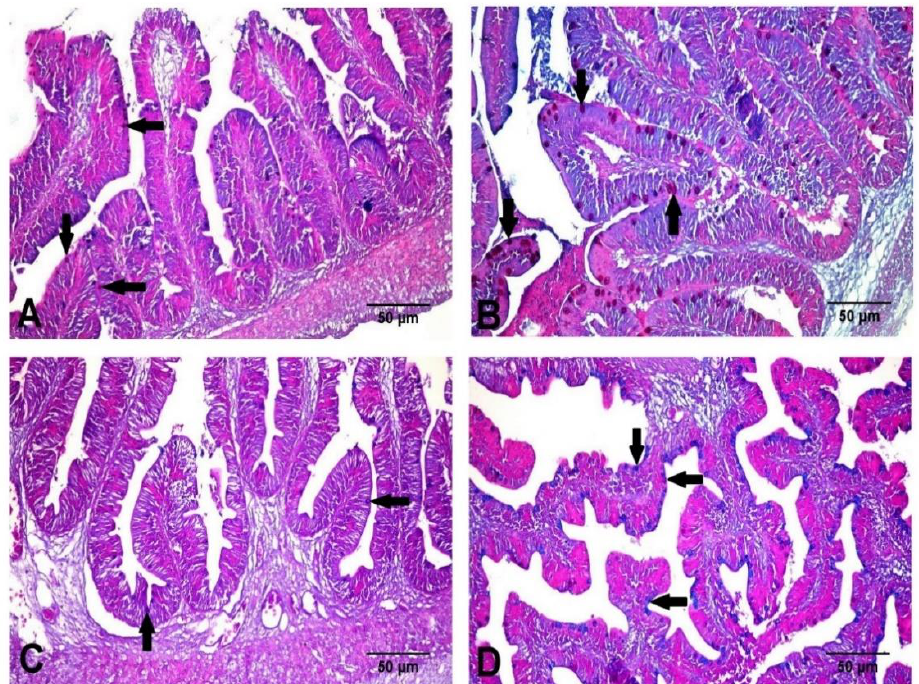
Figure 8. Histological examination of the intestines of the control and Hilyses-treated groups stained with Alcian blue-PAS techniques ( × 200). ( A ). Control group showing few goblet cells containing neutral mucins (arrow); ( B ). Hilyses-treated group showing numerous goblet cells containing neutral mucins (arrow); ( C ). Control group showing small numbers of goblet cells containing acid mucins (arrow); ( D ). Hilyses-treated group showing large numbers of goblet cells containing acid mucins (arrow).